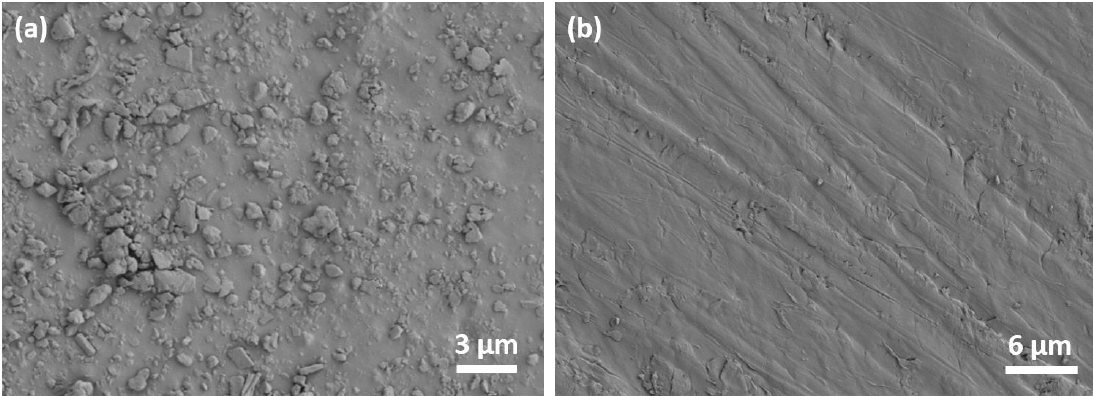
Figure 11. SEM images of the abraded surface of ( a ) the SBS and ( b ) the SBS filled with 10 wt.% GO.